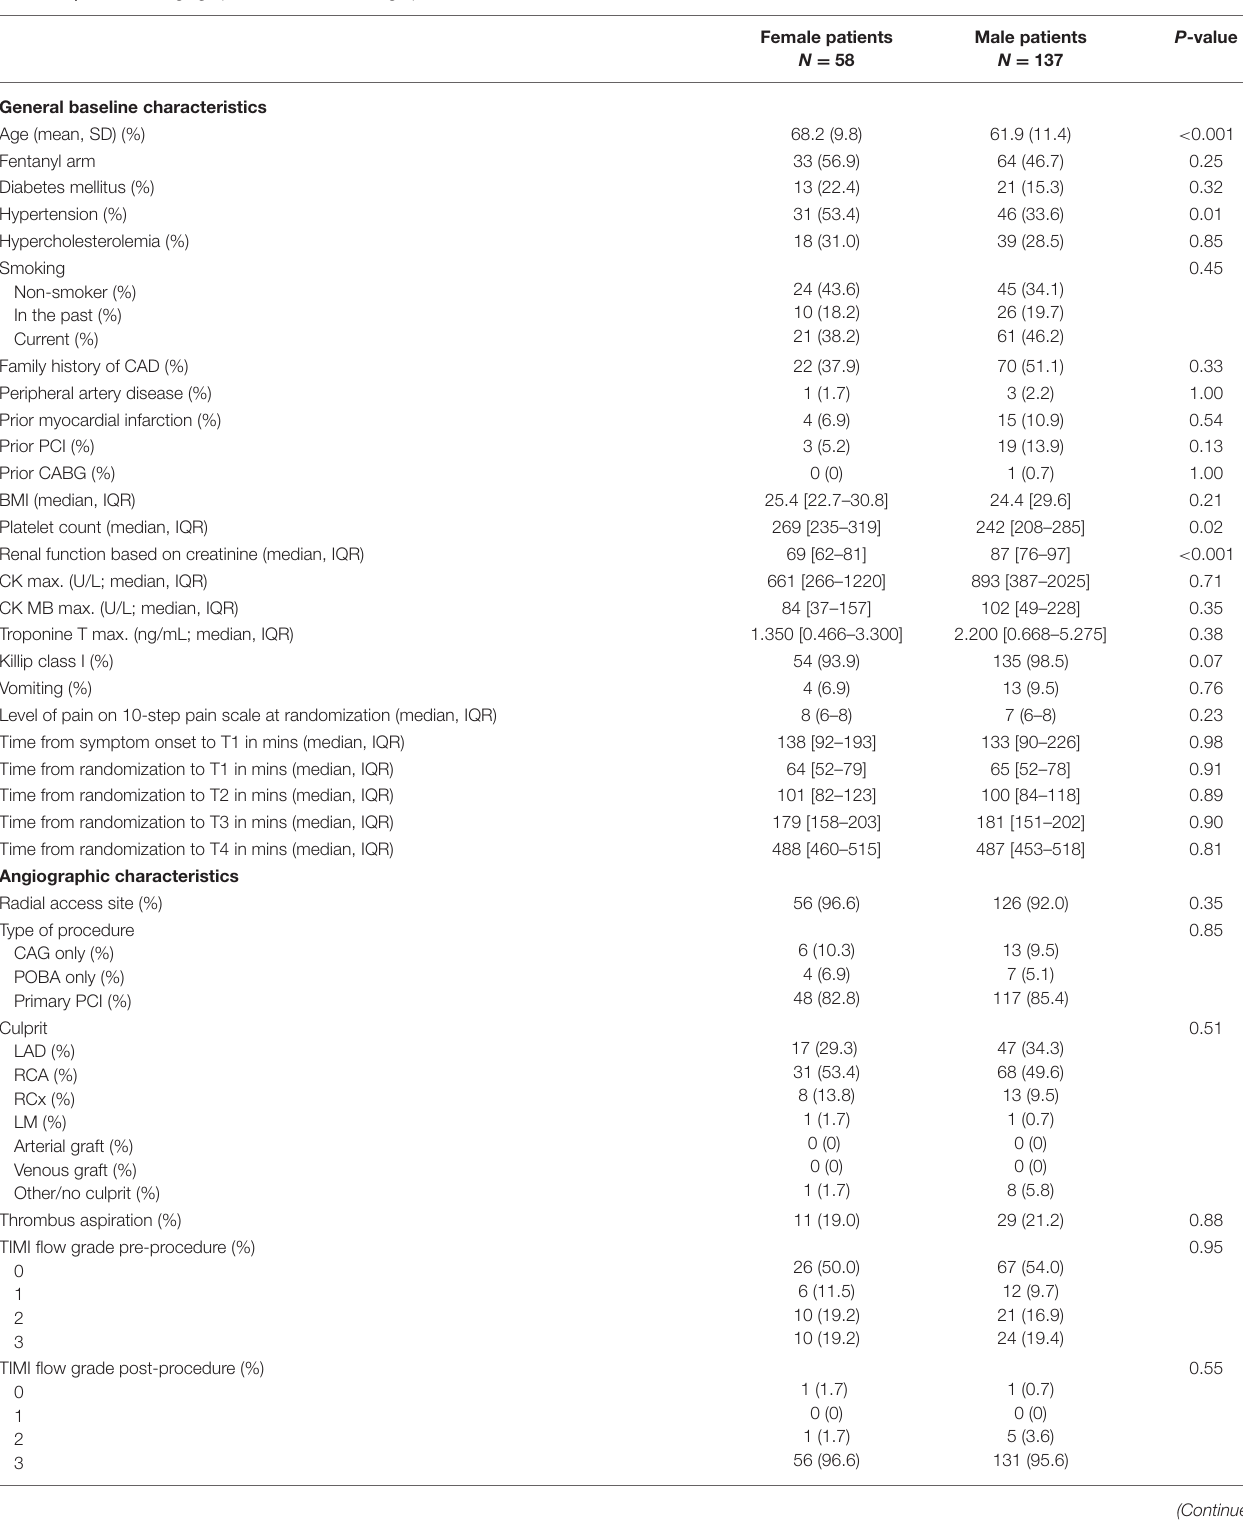
TABLE 1 | Baseline, angiographic and electrocardiographic